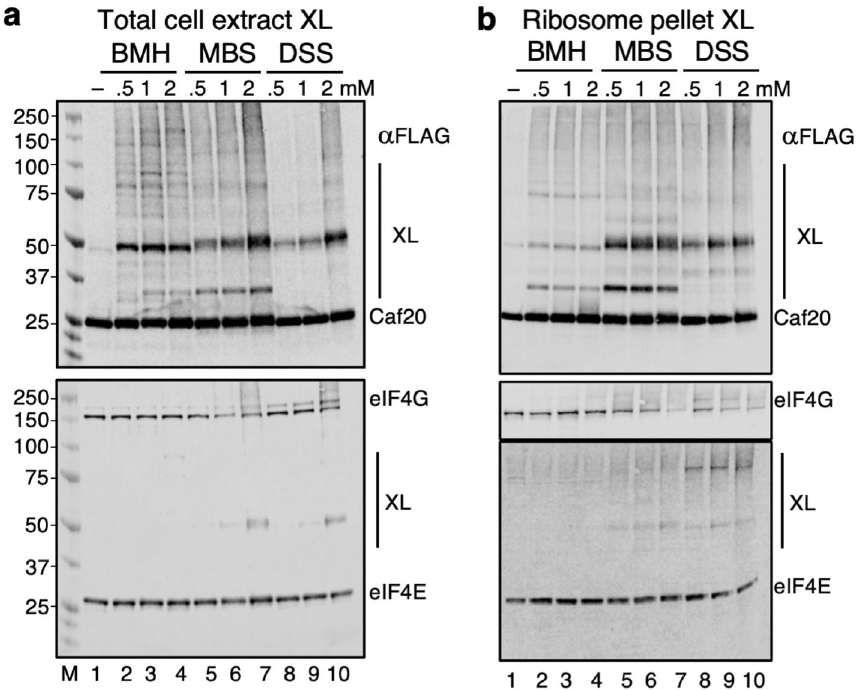
Figure 4. Caf20 crosslinks to proteins associated with ribosomes. ( a ) Western blotting whole cell extracts from Caf20-Flag cells following treatment with BMH, MBS and DSS (0.5, 1 or 2 mM). Probed with Flag, eIF4G and eIF4E antibodies. ( b ) As panel a except for samples enriched in ribosomes by sucrose cushion. lanes 1 ‘–’ samples treated with DMSO solvent